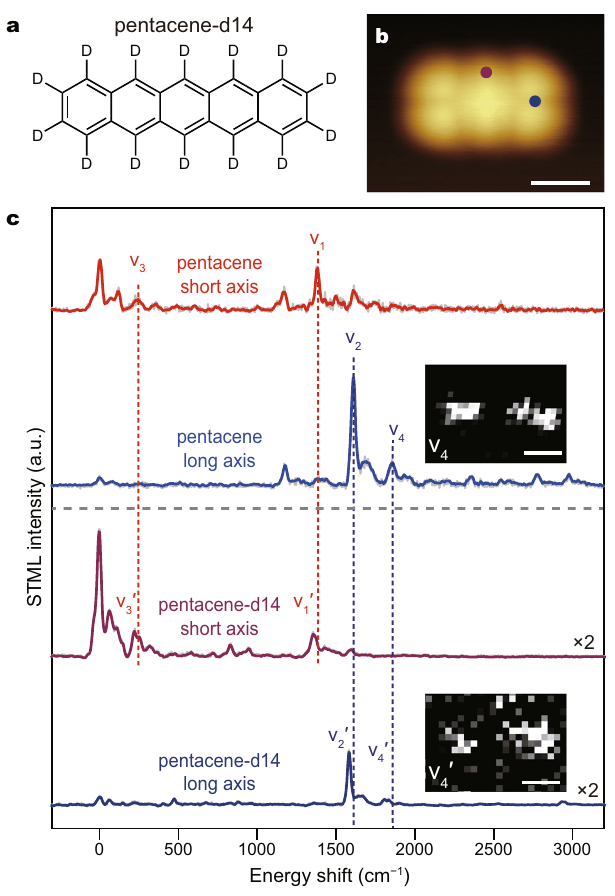
Fig. 4 STML measurements on a single perdeuterated pentacene molecule. a Molecular structure of perdeuterated pentacene (noted as pentacene-d14). b STM image of a single pentacene-d14 molecule adsorbed on 4ML-NaCl/Ag(100) (4 × 3.5nm 2 ; − 3 V, 2pA). c Typical STML spectra from a perdeuterated pentacene molecule acquired at the positions marked in b ( − 3 V, 2pA, 60s), plotted as energy shifts with respect to the 0 – 0 electronic origin. The raw data are plotted in gray lines. The corresponding STML spectra from a pentacene molecule are also plotted for comparison. The insets show the energy-resolved spectroscopic images (3.7× 2.6nm 2 ; − 1 ) of a single pentacene molecule − 3 V, 2pA) for the v 4 mode (1855±5 cm (10s per pixel) and the v 4 ′ mode (1806±5 cm − 1 ) of a perdeuterated pentacene molecule (5s per pixel), respectively. Scale bars,